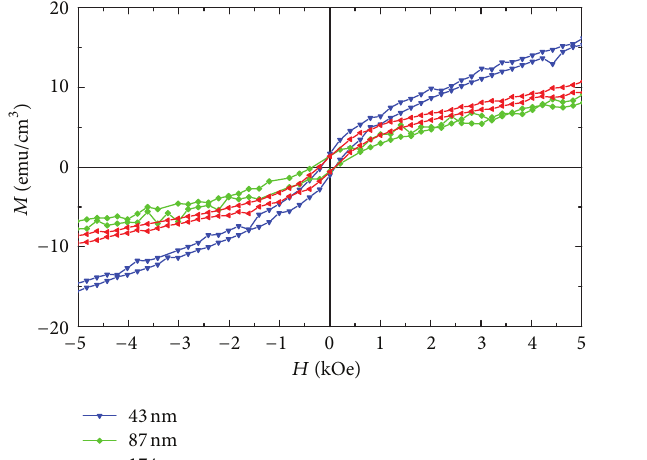
Figure 9: Grazing incidence XRD patterns Bi 1−